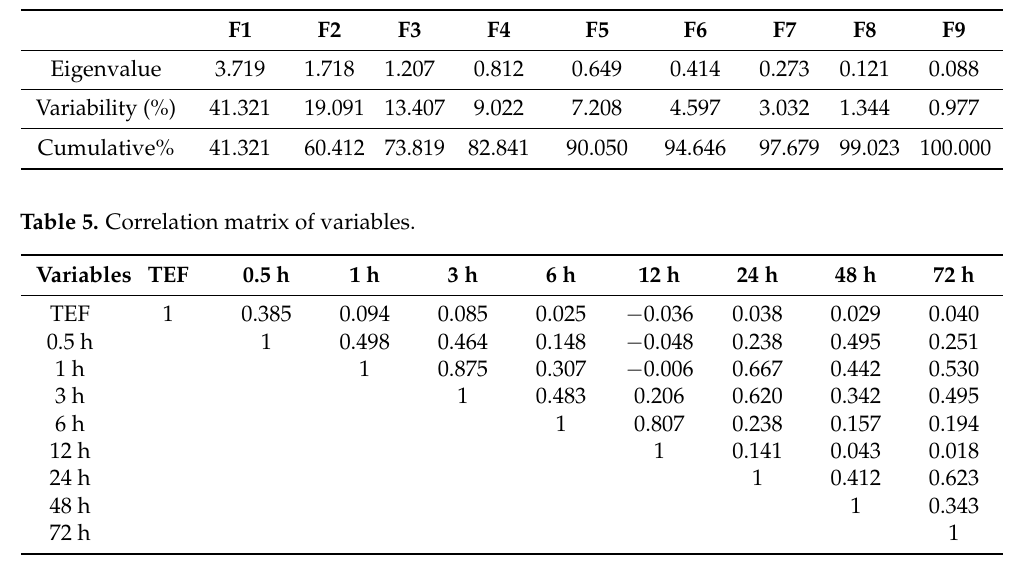
Figure 2. ( A ) PCA score plot of correlation circles showing the different collections of samples based on their metabolite pattern. Different quadrants show similarity of metabolites’ pattern and vice versa. ( B ) Heat map of analyzed metabolites obtained from HPLC and UHPLC–MS profiling. Row correspondence to abundant and metabolite causing differentiations, while column indicates metabolites abundance with respect to sample. Abundancy of metabolites is shown in different colors: red color represents the higher metabolites abundancy, green color represents lower abundancy, and black color represents very lower abundance of metabolites. Table 4. Eigenvalues of different variables.